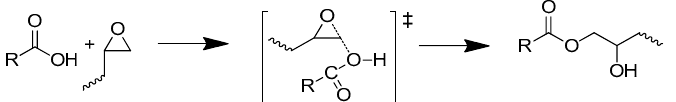
Table 2. Rate constants and regression constants.